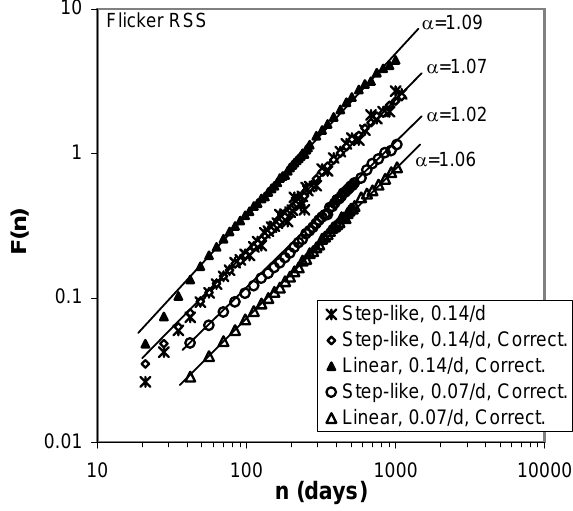
Figure 2 . Bilogarithm plot of the fluctuation function F ( n ) vs. time scale n , for a RSS having flicker-noise correlation properties (theoretical α = 1.03). The DFA results are displayed for the series interpolated by both step-like and linear method, and resampled by both 0.07 day -1 and 0.14 day -1 frequencies. The label “correct.” refers to DFA coupled to PRS and small- n correction techniques (see text). As the calculated F ( n ) functions almost overlap, they have been multiplied by an arbitrary factor so as to be shifted for clarity. This procedure was repeated in the following figures whenever required.